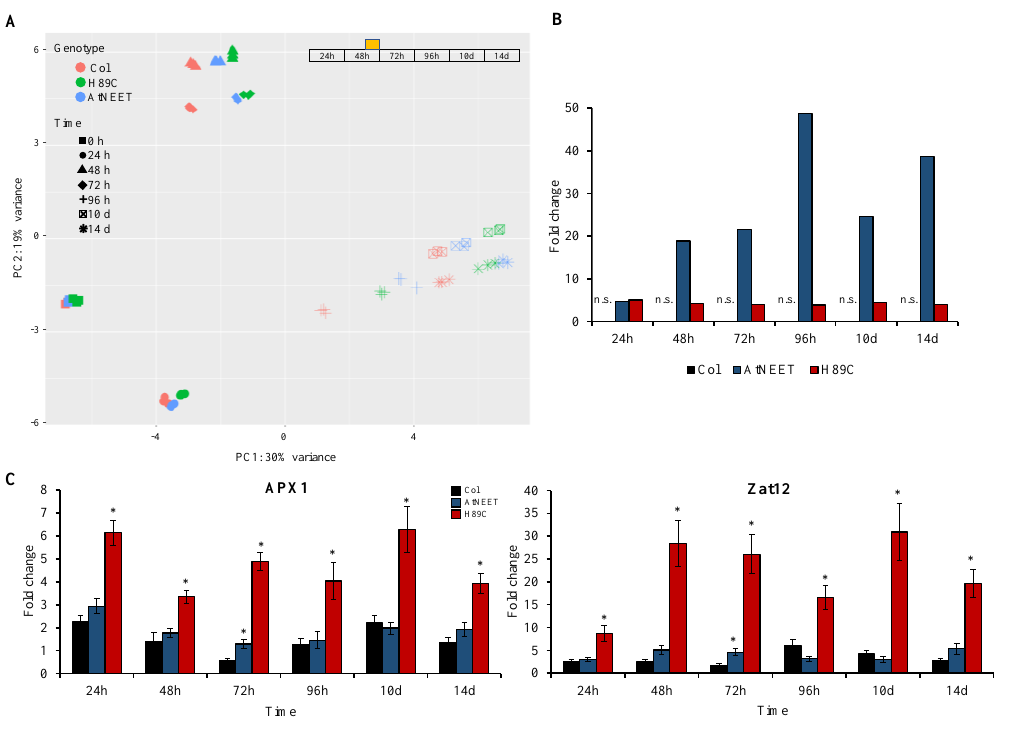
Figure 3. Proteomics analysis and expression measurements of selected transcripts at the different time points. ( A ) Principal component analysis (PCA) of the proteomics results obtained for the different lines at the different time points of the experiment. ( B ) Expression level of AtNEET in Col, AtNEET, and H89C plants at the different time points. ( C ) Steady-state transcript expression levels of APX1 and Zat12 in Col, AtNEET, and H89C plants at the different time points. All experiments were repeated at least three times with similar results. Asterisks (*) denote statistical significance with respect to control (Col) at p < 0.05 (Student t -test, SD, n = 5). Abbreviations used: APX1, ascorbate peroxidase 1; n.s., not significant; PC, principal component; Zat12, zinc finger protein ZAT12.